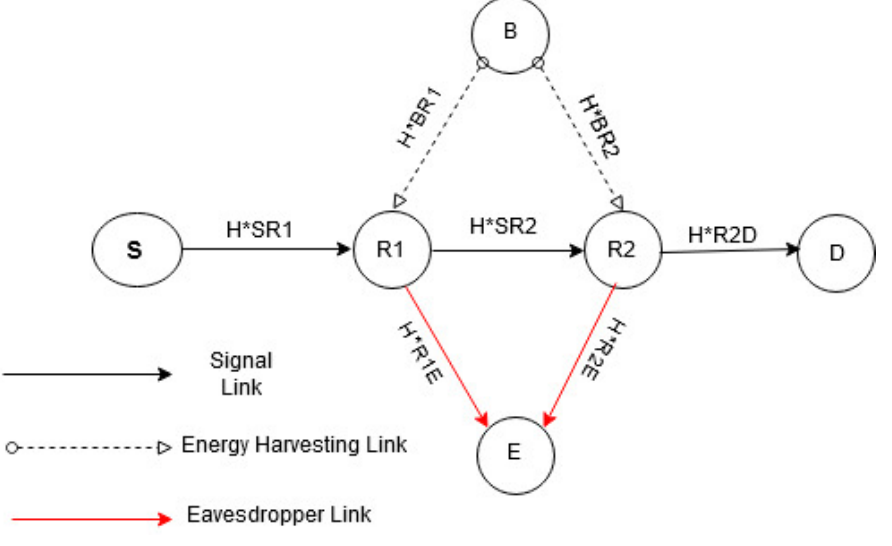
Figure 1. System model of the secrecy relay network.